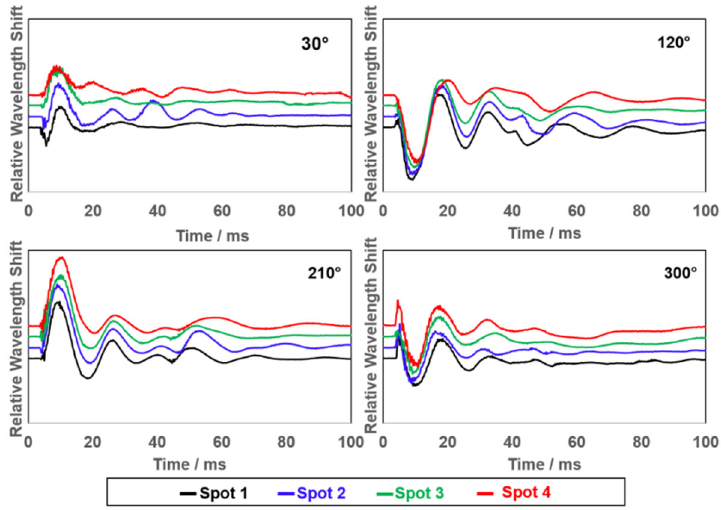
Figure 5. First 100 ms of the transient oscillatory signals resulting from pendulum impacts for four selected directions (30°, 120°, 210° and 300°) and four impact spots with different vertical heights selected directions (30 ◦ , 120 ◦ , 210 ◦ and 300 ◦ ) and four impact spots with different vertical heights from 1 to 4. from 1 to